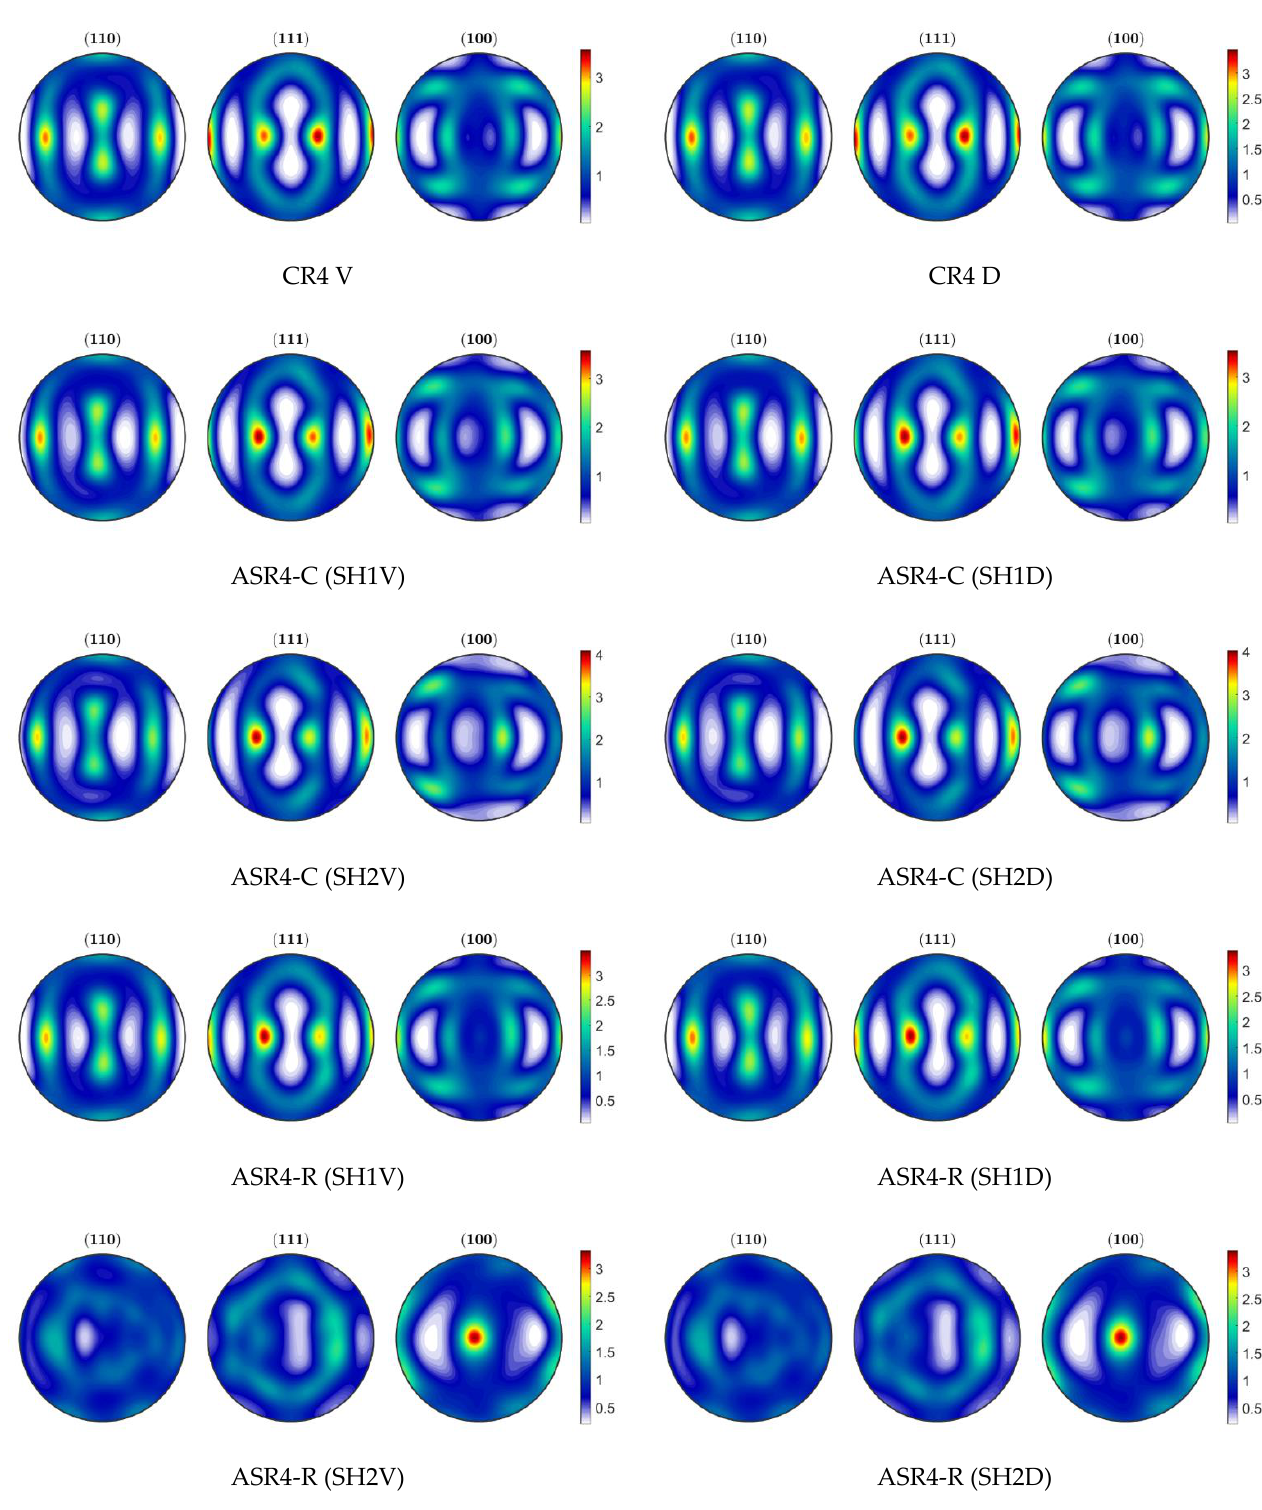
Figure A8. Pole figures for the fourth pass with a 20% thickness reduction per pass.